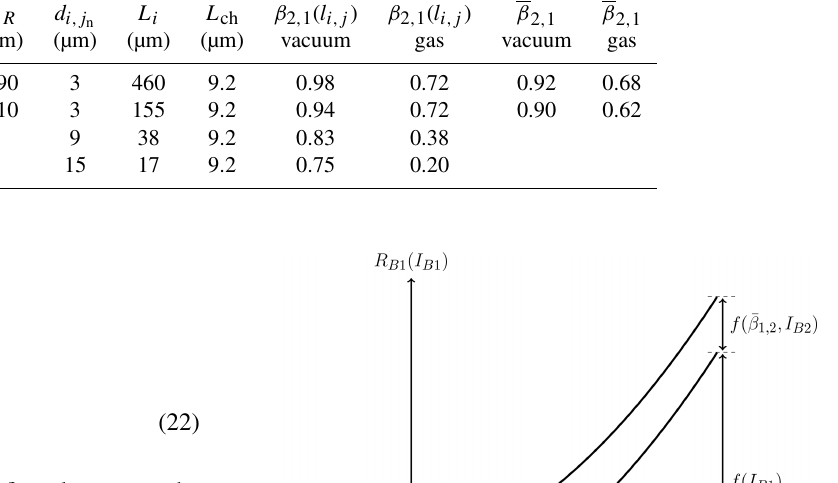
Figure 4. SEM micrographs of the various manufactured test structures with the relevant thermal linkage parameters indicated. Regions are identified and defined as parts of the design that have a constant separation distance d i over the entire resistance length of that region. (a) A suspended plate structure (Ti1) with optimal thermal linkage. (b) A suspended plate structure (Ti2) with high thermal linkage. Table 3. A summary of the device parameters required by the proposed analytic model to determine the thermal linkage. Device